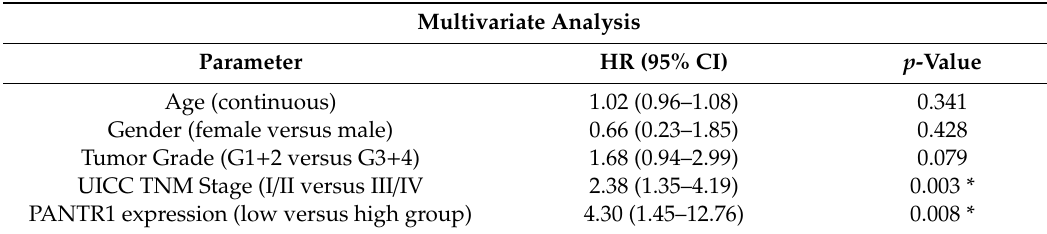
Table 2. Multivariate Cox regression model of clinicopathological parameters and PANTR1 levels for the prediction of recurrence-free survival in ccRCC patients. Asterix (*) indicates p -values < 0.05. Abbreviations: CI = confidence interval; HR = hazard ratio.